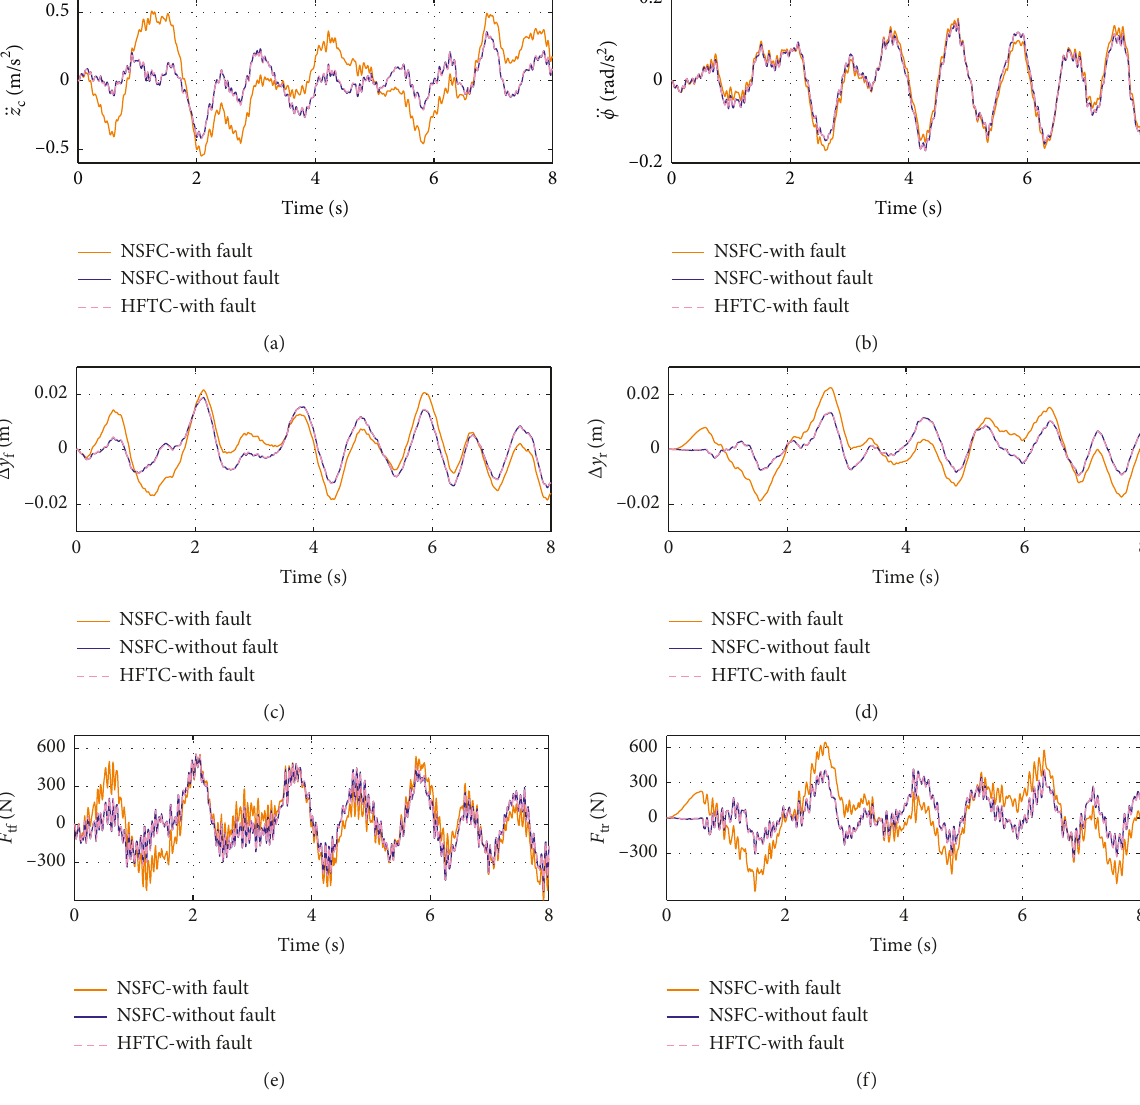
Figure 7: The response comparisons of ASS with the sinusoidal fault signal under the random road disturbance.